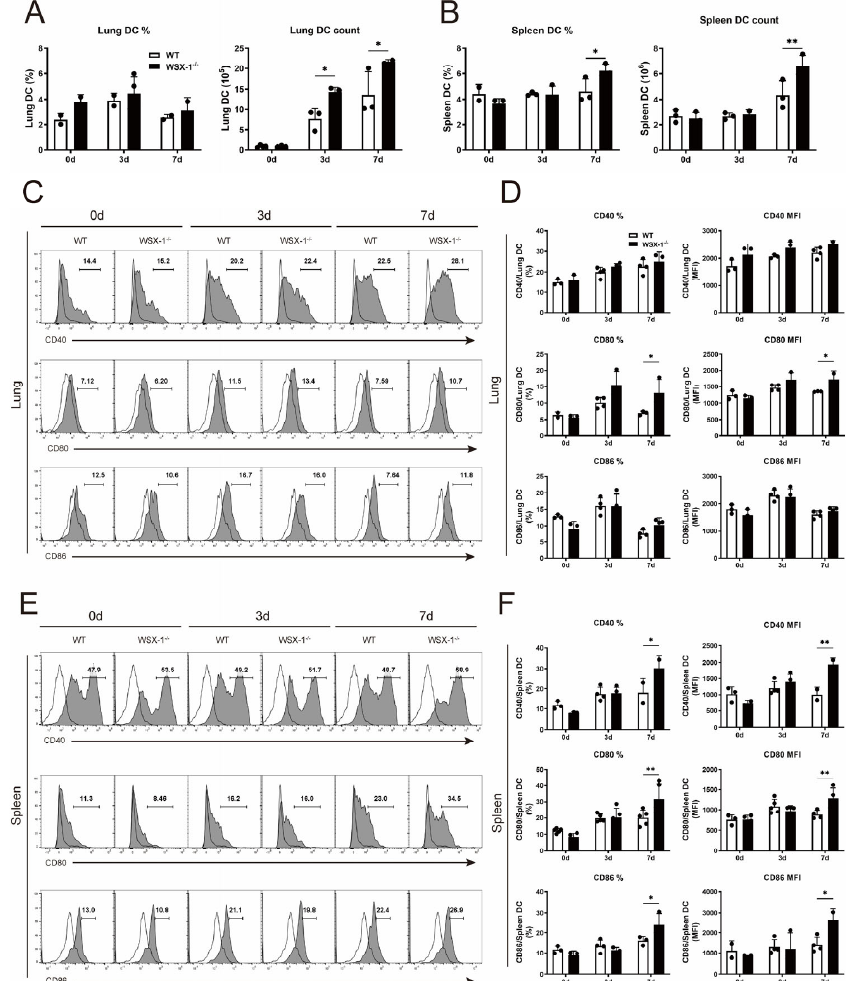
Figure 4. DCs accumulation and phenotypic maturation in WSX-1 − / − mice following C. muridarum respiratory infection. The lung and spleen single cells of WT and WSX-1 − / − mice on days 0, 3, and 7 p.i. were prepared. ( A , B ) The frequencies and total numbers of pulmonary DCs ( A ) and splenic DCs ( B ) were detected by flow cytometry. ( C – F ) The CD40, CD80, and CD86 expressions (shaded histo- gram) with fluorescence minus one (FMO) control (solid lines) on pulmonary DCs ( C ) and splenic DCs ( E ) were analyzed by flow cytometry. The percentages and MFI of positive cells at indicated times after infection were indicated ( D , F ). Data are shown as means ± SD, representing one of three independent experiments (n = 3–5/group/experiments). Statistical significances of differences are determined by two-way ANOVA. * p < 0.05, ** p < 0.01. Abbreviations: C. muridarum /Cm, Chlamydia muridarum ; WSX-1 − / − , IL-27R α -deficient; p.i., post-infection; FMO, fluorescence minus one; MFI: mean fluorescence intensity.